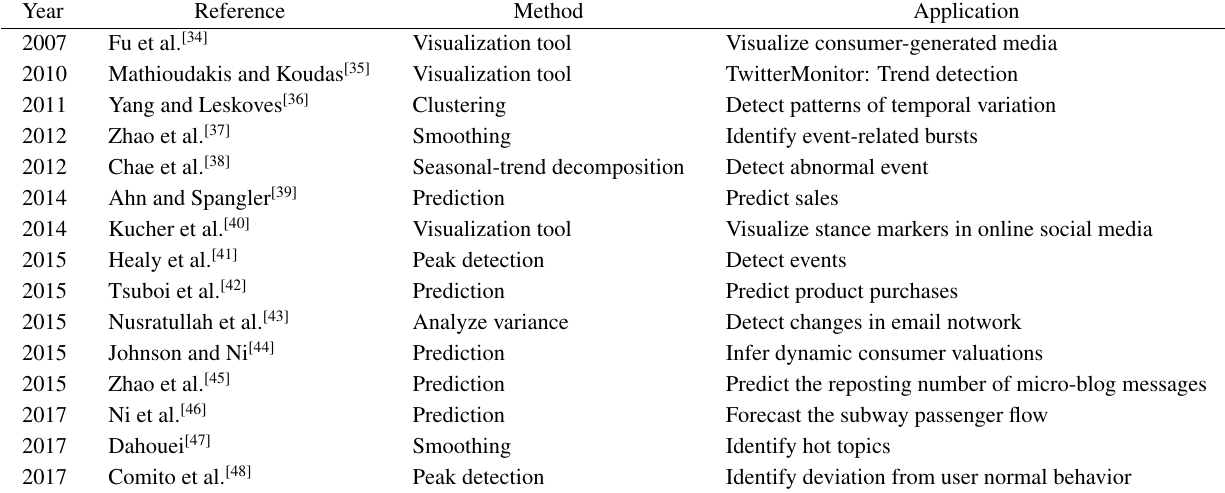
Table 2 Summary of previous works in time series analysis.